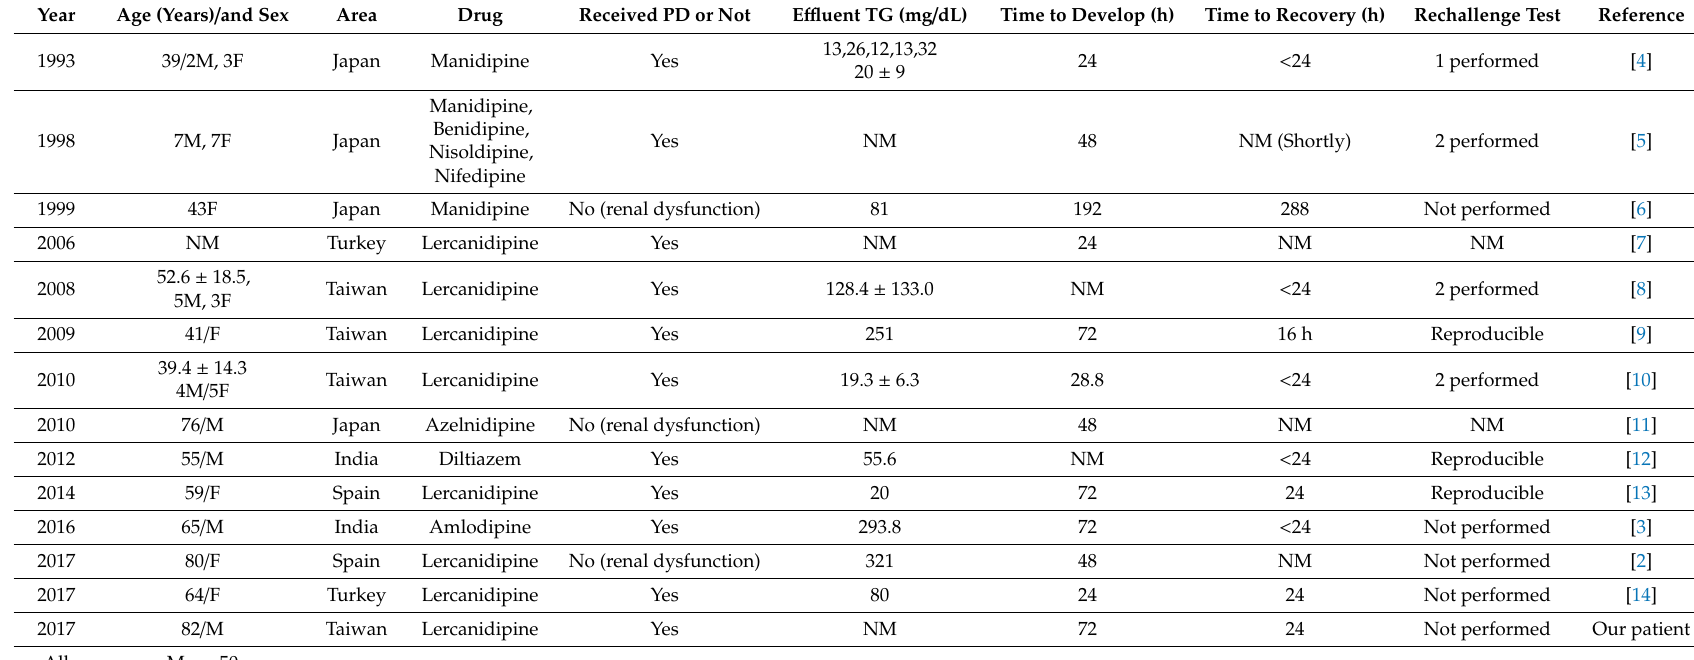
Table 1. Clinical and laboratory findings of all